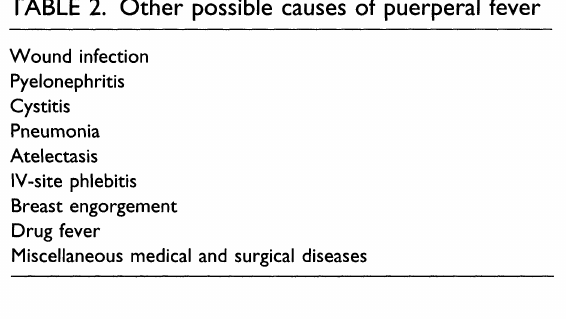
TABLE 2. Other possible causes of puerperal fever Wound